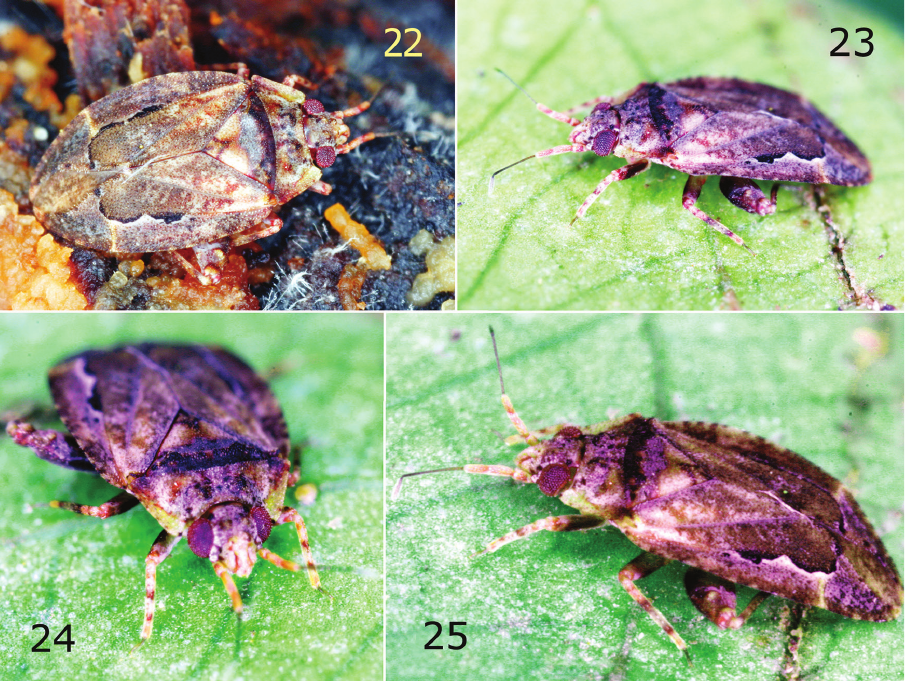
sis 2006: fig. 1H; Yeshwanth et al. 2016: Figs 34, 39, 45, 52, 57, 62), Mimofulviella Wolski (Wolski 2008), Euchilofulvius Poppius (Yeshwanth et al. 2016: fig. 10) and Fulvius Stål (Yeshwanth et al. 2016: Figs 16, 21, 34, 39) and is very common among other fulviine genera (Wolski, pers. obs.). In other cylapine tribes the dorsal wall of the